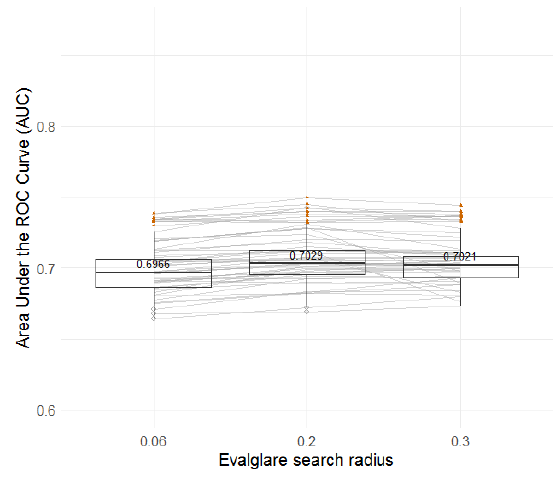
Figure 20. Boxplots of AUC for the three search radius (field study).